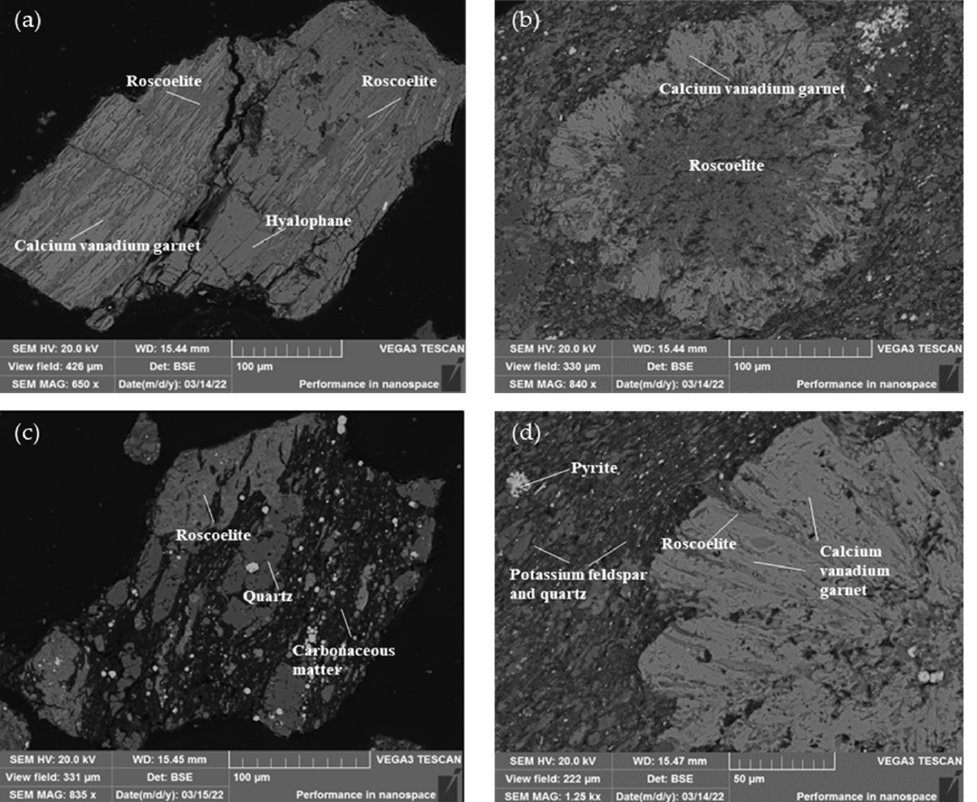
Figure 5. Scanning electron microscope images of roscoelite (K{V 2 [AlSi 3 O 10 ]}(OH) 2 ) in the stone coal: ( a ) picture of roscoelite associated with calcium vanadium garnet and hyalophane ((K,Ba)Al(Al,Si) 3 O 8 ); ( b ) picture of roscoelite associated with calcium vanadium garnet; ( c ) picture of roscoelite associated with quartz and carbonaceous matter; ( d ) picture of roscoelite associated with calcium–vanadium garnet and other gangue minerals.